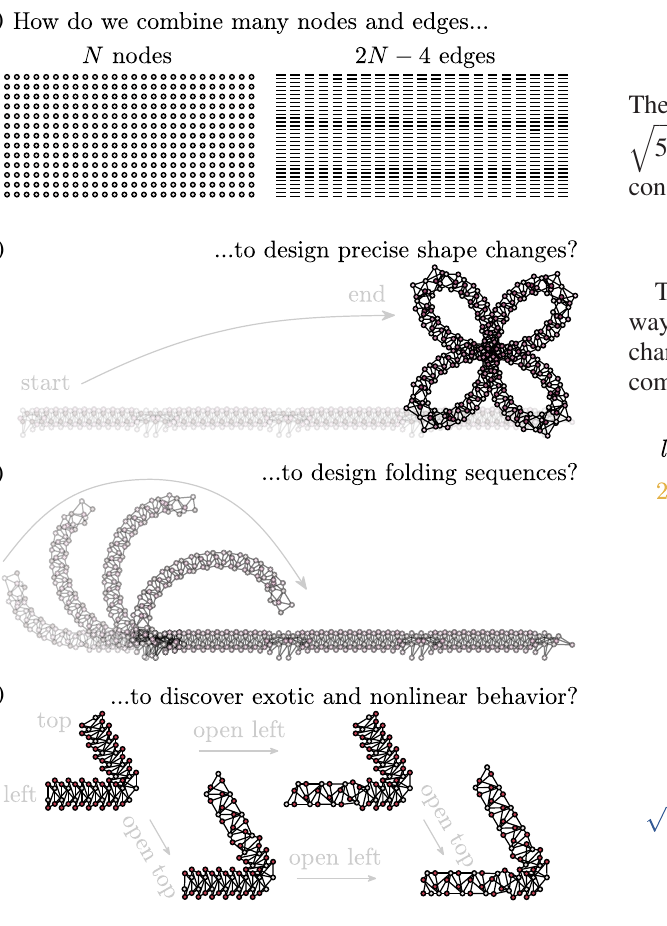
FIG. 2. Motivation for the results. (a) Set of 338 nodes and 672 edges that, through our results, can be designed to have (b) precise shape changes and (c) folding sequences. (d) Network that has been designed to behave as a mechanical AND gate.